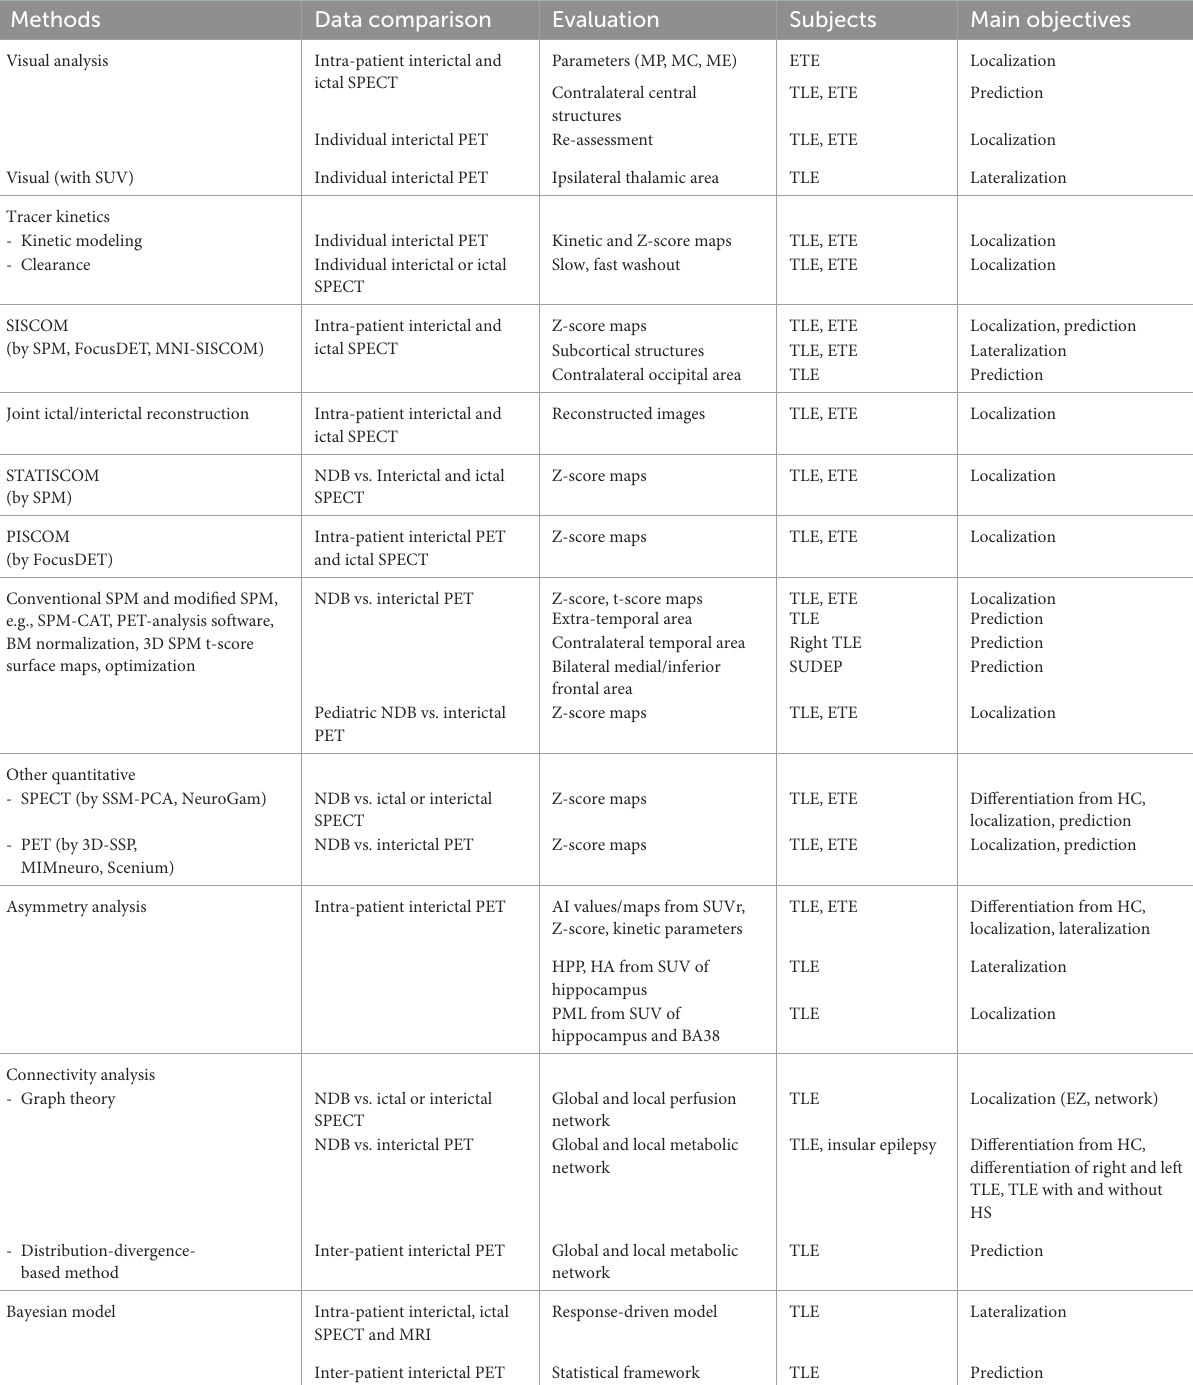
TABLE 2 Overall methods and software for EZ localization and surgical outcome